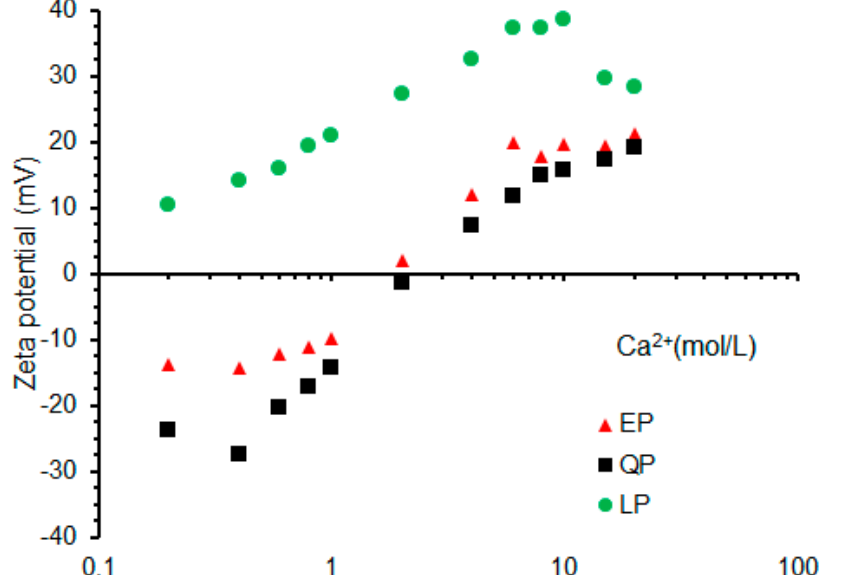
Figure 8. Zeta potential of EP, QP and LP in Ca (OH) 2 solutions with different Ca 2+ concentrations.